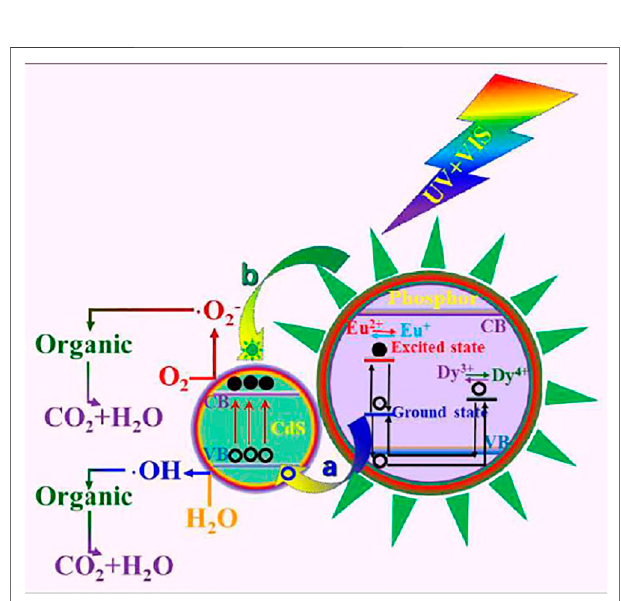
FIGURE 6 | Photocatalytic mechanism of CdS-sheathed SrAl 2 O 4 : Eu 2+ , Dy 3+ heterojunction photocatalysts (Xiao et al., 2018). Adapted from ref. (Xiao et al., 2018). Copyright © 2018 Royal Society of